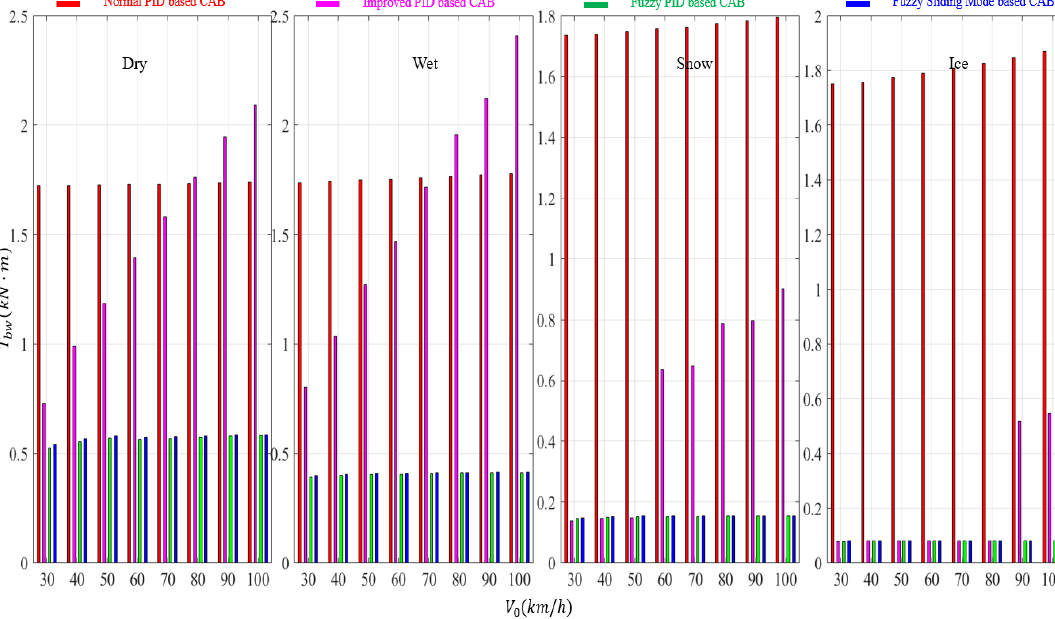
Figure 6. The T bw comparison under different CABs on various road conditions. Figure 7 show real-time wheel slip ratio comparison